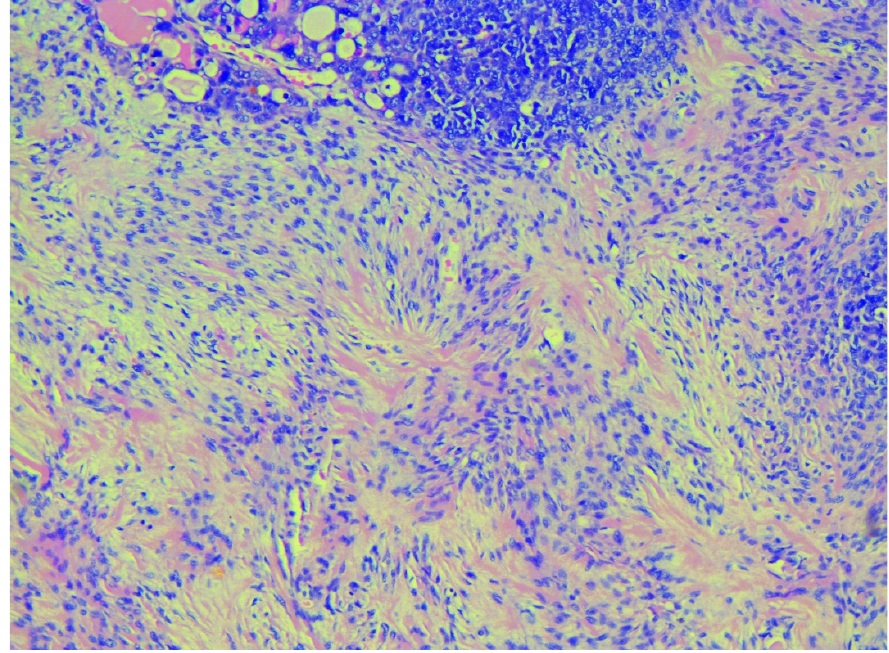
Figure 3. Starburst appearance in the sarcomatous component typical for stromal sarcoma, H&Ex200.